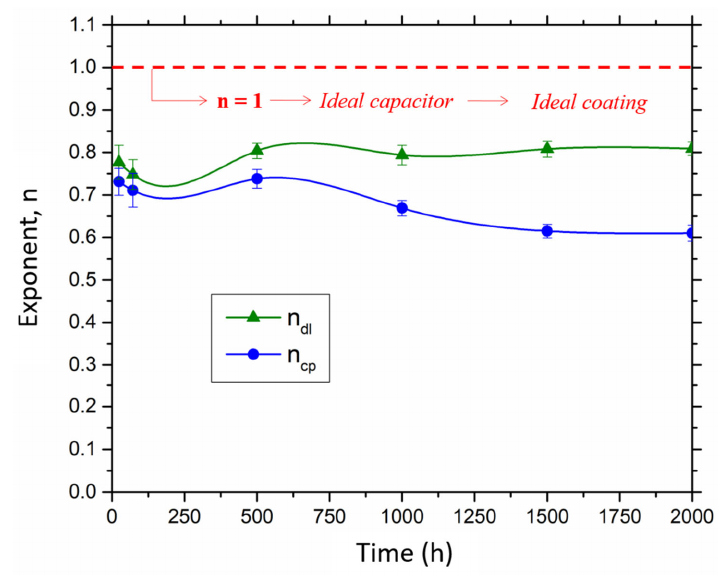
Figure 8. Variation in n dl and n cp exponents during testing.